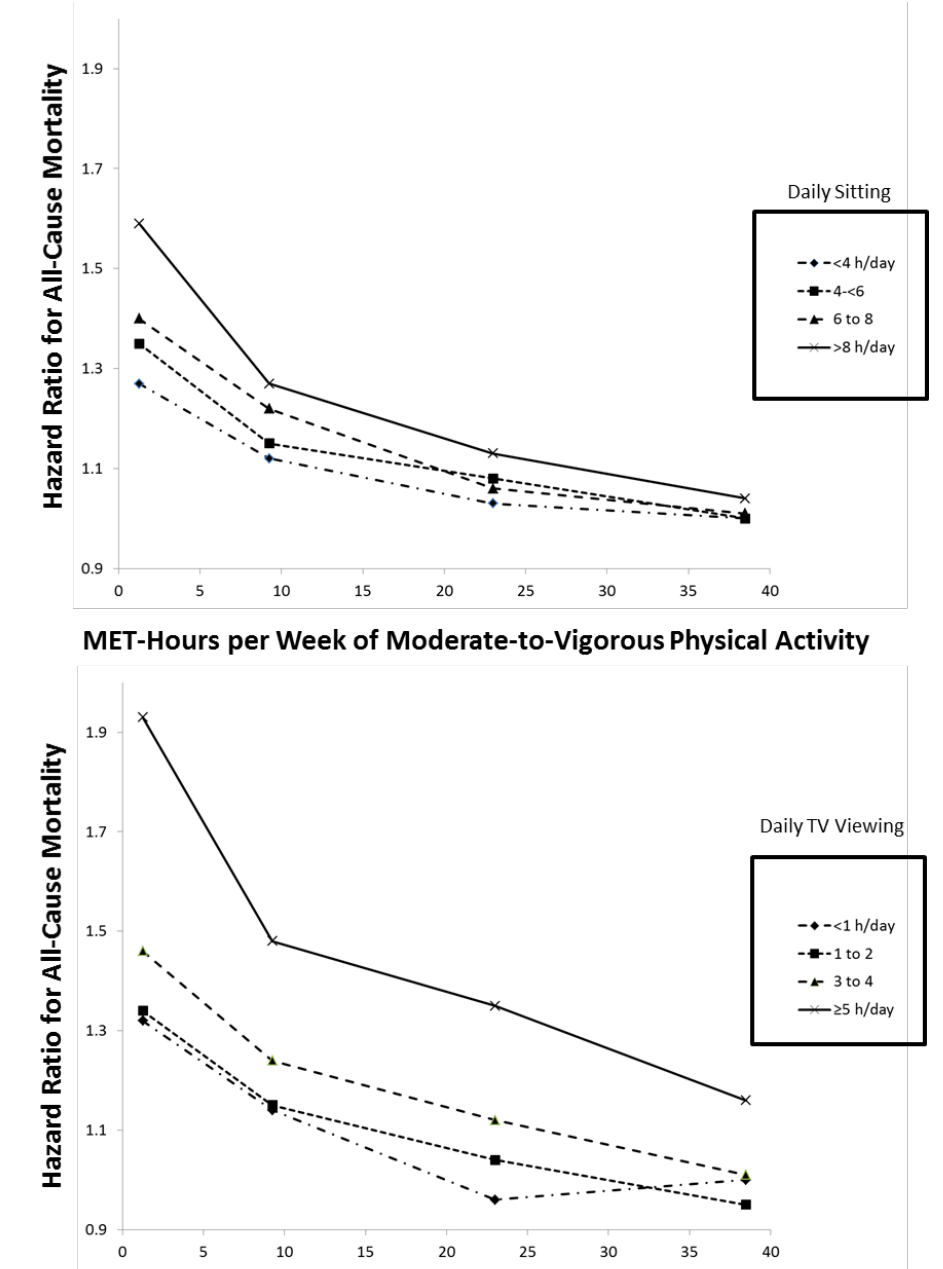
Figure F2-4. Relationship Between Moderate-to-Vigorous Physical Activity and All-cause Mortality, Stratified by Amounts of A) Sitting Time and B) TV